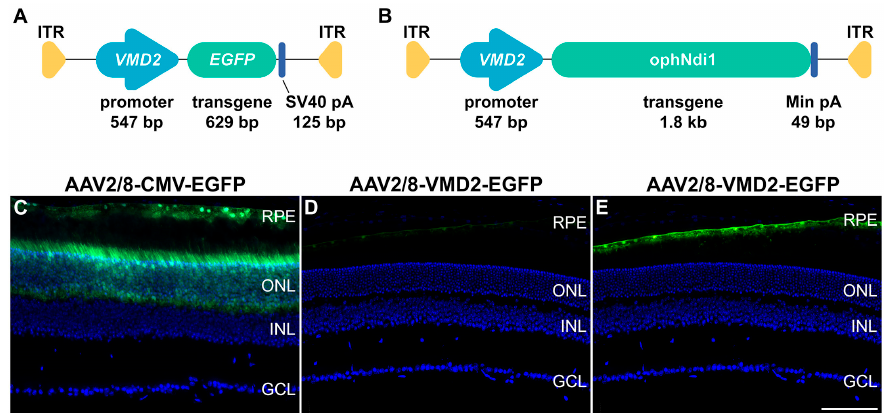
Figure 1. Diagrammatic representation of the plasmid constructs VMD2 -ophNdi1 ( A ) and VMD2 - EGFP ( B ), which were utilised to generate AAV2/8-VMD2-EGFP and AAV2/8-VMD2-ophNdi1 viral preparations. The VMD2 promoter and EGFP and ophNdi1 transgenes, the minimal PolyA, ITRs and sizes are indicated. ( C – E ) Comparison of cell type specificity and EGFP expression level from the VMD2 and CMV promoters in murine retina. Two-month-old 129 S2/SvHsd mice were sub- retinally injected with 3 × 10 9 vg of AAV2/8-CMV-EGFP ( C ) or AAV2/8-VMD2-EGFP ( D , E ). Four weeks post-injection, eyes were enucleated, fixed in 4% PFA, cryosectioned, and processed for and analysed by fluorescent microscopy. Green and blue represent EGFP and DAPI (nuclear counter- stain) fluorescence, respectively. Panels ( C , D ) were displayed using the full intensity range of EGFP fluorescence. Panel ( E ) corresponds to the same microscopy image as panel ( D ); however, in panel ( E ), the displayed EGFP fluorescence intensity range was focused on the lower intensity values, which enabled the visualisation of lower EGFP levels. EGFP fluorescence intensity levels were meas- ured in the RPE for both promoters, and levels were found to be ~6.5-fold lower from VMD2 com- pared to CMV . RPE: retinal pigment epithelium, ONL = outer nuclear layer, INL = inner nuclear layer, GCL = ganglion cell layer. Scale bar for retinal sections ( E ) = 100 μ m.